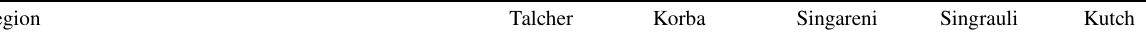
Table 3 Ambient conditions at power plant clusters in India Region Talcher Korba Singareni